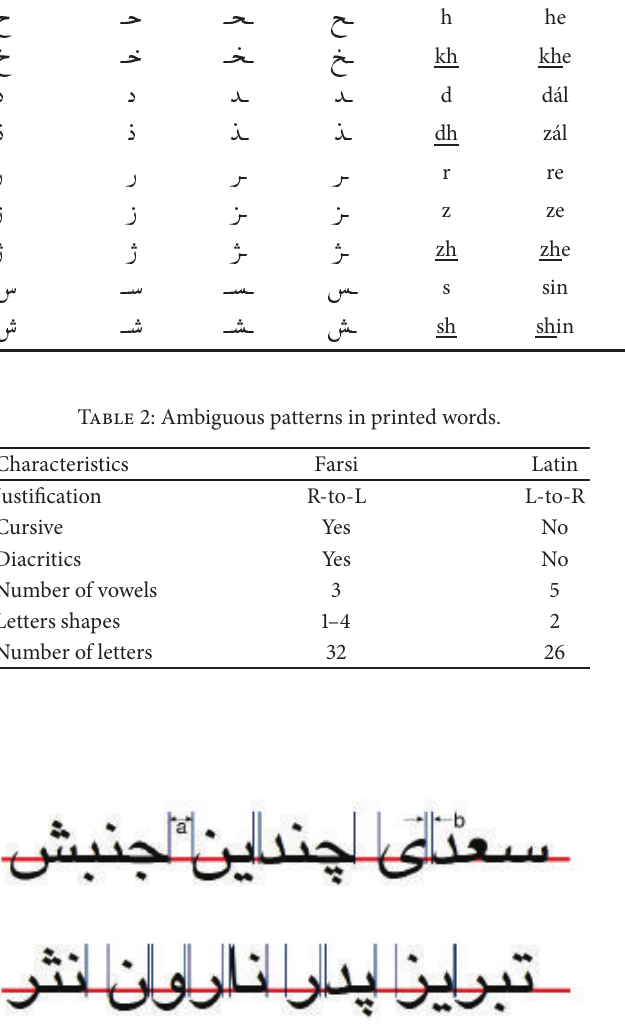
Figure 1: Sample of Persian script and virtual baseline [6].